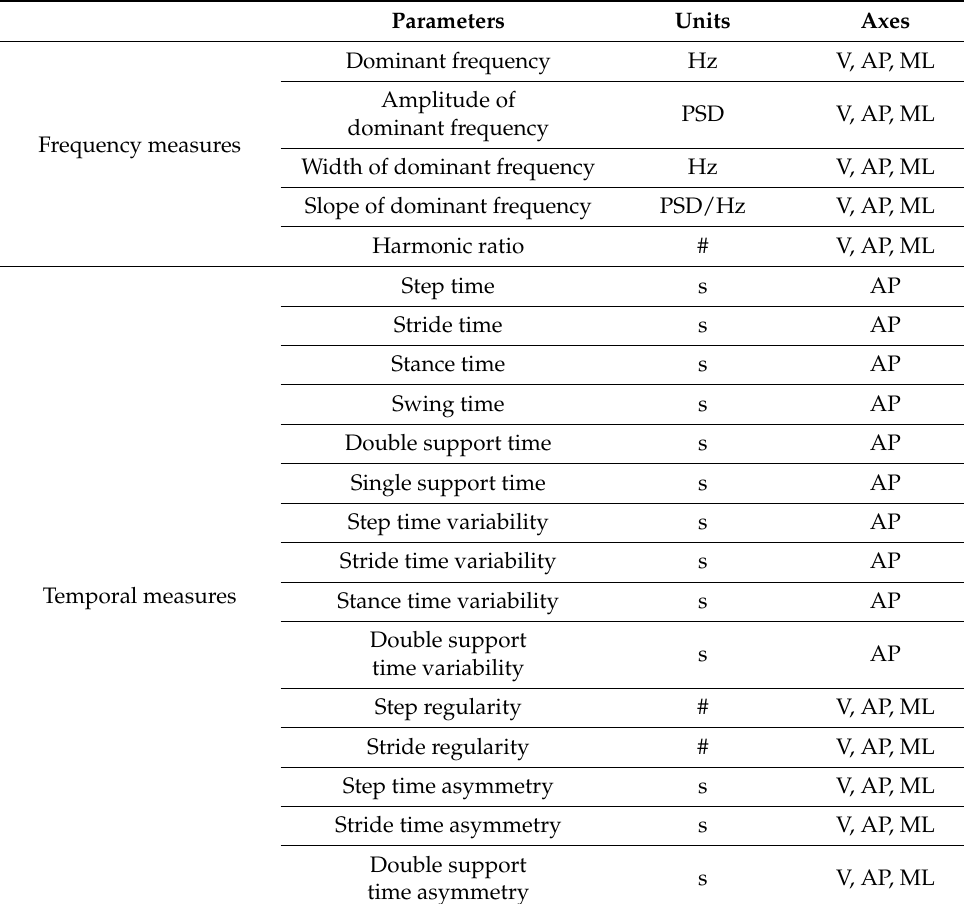
Table 2. Gait parameters related to the quality of walking, in frequency and time domains. Parameters Units Axes